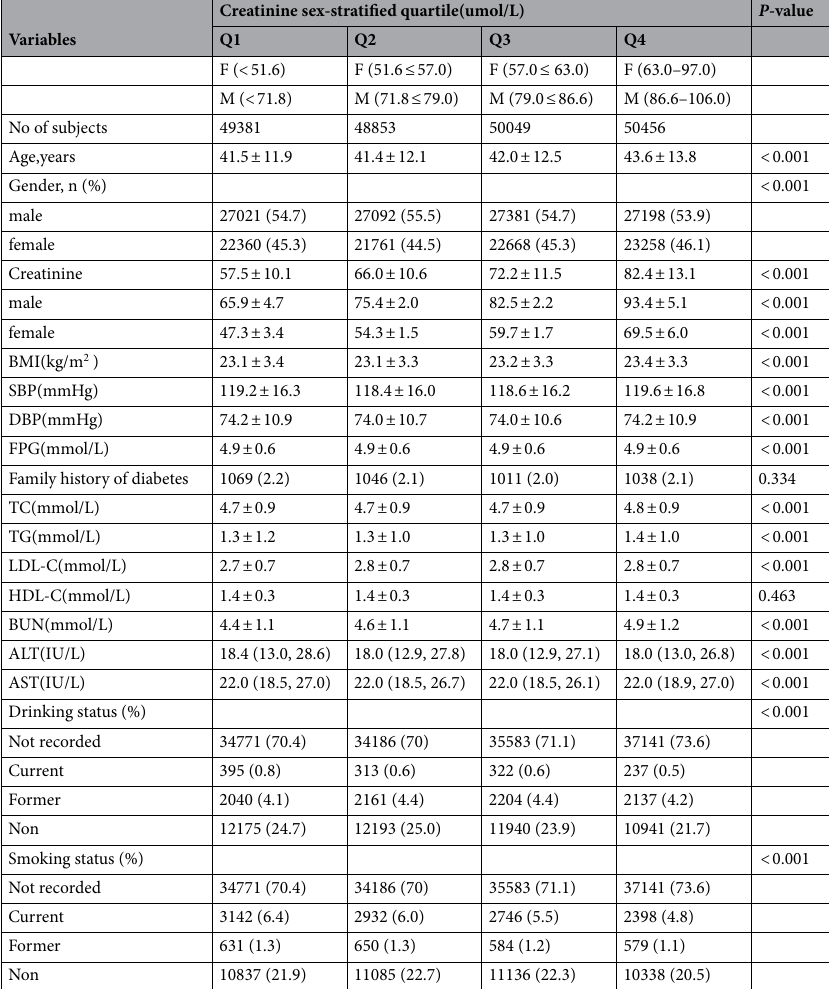
Table 1. Baseline characteristics of participants. F female, M male, BMI body mass index, SBP systolic blood pressure, DBP diastolic blood pressure, FPG fasting plasma glucose, TC total cholesterol, TG triglyceride, LDL- C low-density lipid cholesterol, HDL-C high-density lipoprotein cholesterol, BUN blood urea nitrogen, ALT alanine aminotransferase, AST aspartate